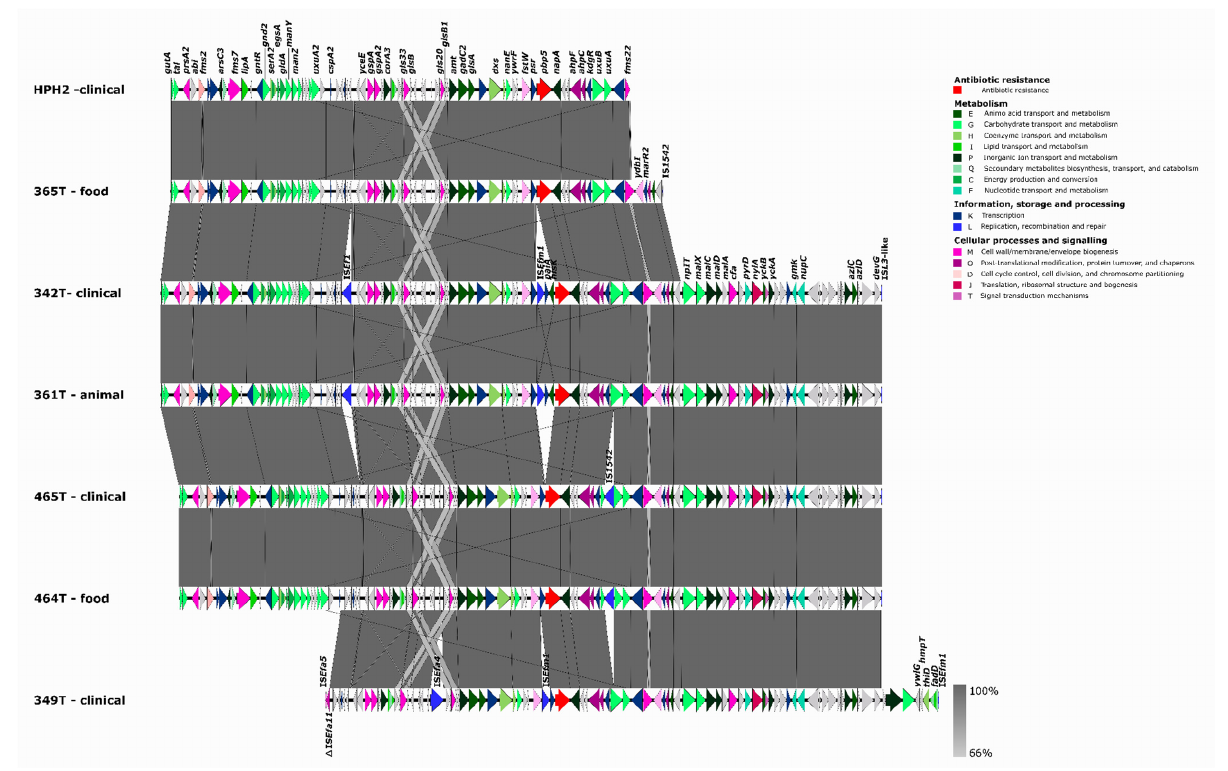
Figure 2. Representation of partial transferable chromosomal genetic platforms containing pbp5 . Mapping and annotation (Geneious Prime version 2020.2.2) of partial transferable pbp5 chromosomal genetic platforms of Tunisian AmpR- E. faecium of this study [365T/ST17 (68260 bp), 342T/ST18 (99914 bp), 361T/ST18 (99914 bp), 465T/ST17 (97354 bp), 464T/ST17 (97354 bp), and 349T/ST80 (84987 bp)] by using the pbp5 -containing contig of the ampicillin-resistant transconjugant